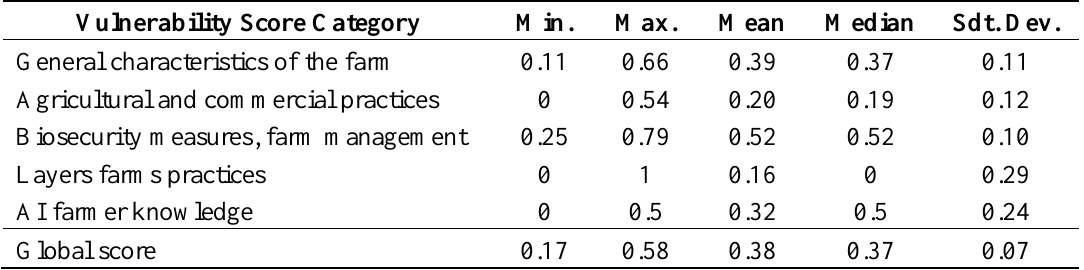
Table 3. Summary statistics for five categories of vulnerability scores of commercial poultry farms in Nakhon Pathom, Thailand, 2011.